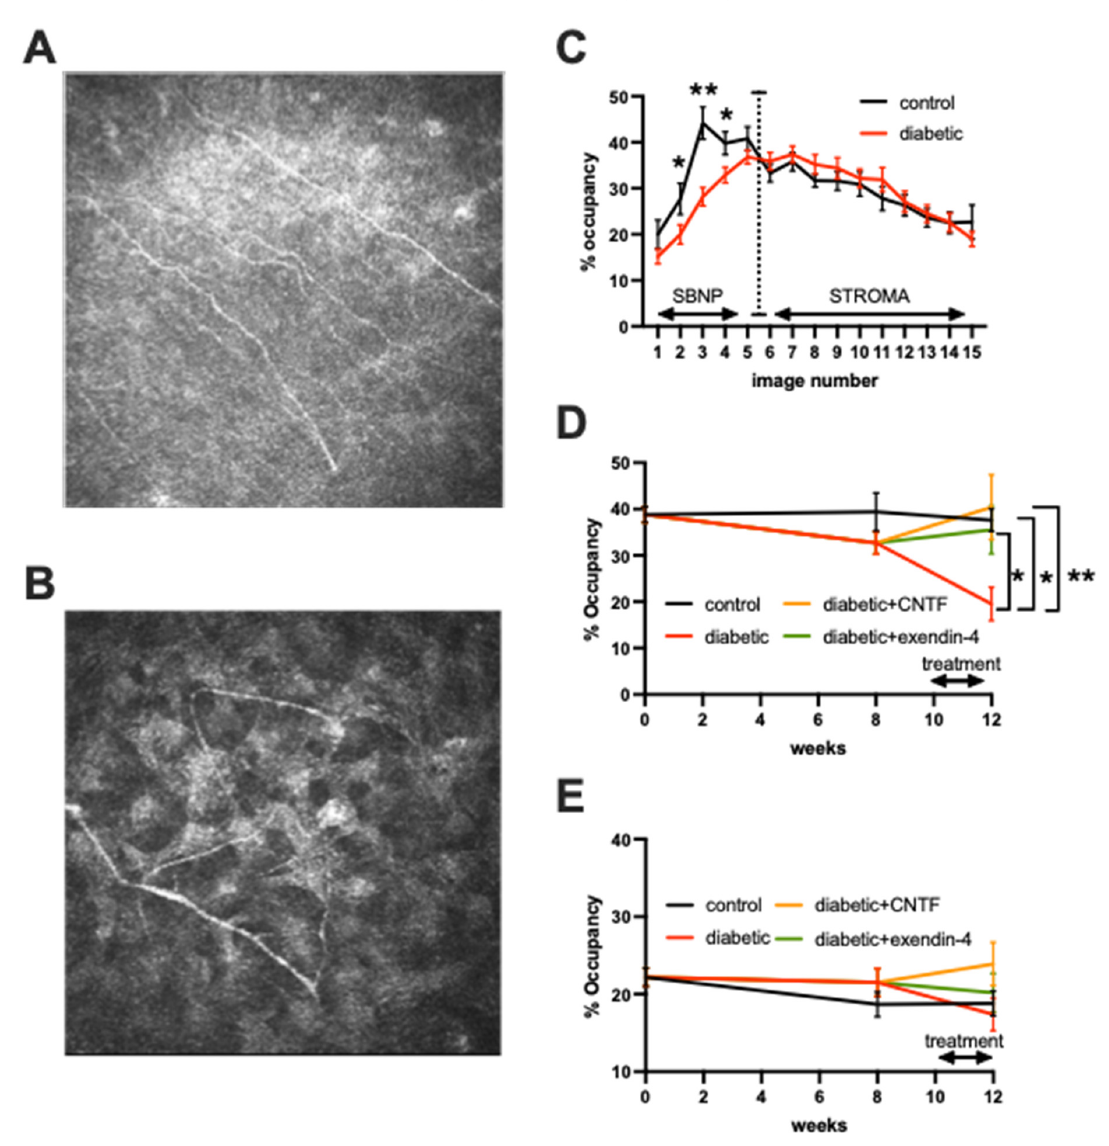
Figure 1. Reversal of corneal neuropathy by topical CNTF or exendin-4 in diabetic mice. Repre- sentative images of sub-basal nerve plexus ( A ) and stromal nerves ( B ) from Swiss Webster mice. Quantification of nerve % occupancy ( C ) of 15 consecutive individual images collected at 2 µ m intervals from the corneal epithelium to the stroma in control mice and mice with 4 weeks of diabetes. Data points are group mean ± SEM of N = 9 control and N = 23 diabetic mice. * = p < 0.05 and ** = p < 0.01 by unpaired test. Quantification of sub-basal nerve plexus ( D ) and stromal nerve ( E ) % occupancy over time in control (N = 9) mice, diabetic mice (N = 9), and diabetic mice treated daily for the last 2 weeks with eyedrops containing CNTF (N = 7) or exendin-4 (N = 7). Data points are group mean ± SEM with between group analysis at study end by one way ANOVA with Dunnett’s post hoc test. * = p < 0.05 and ** = p < 0.01 vs. vehicle treated diabetic mice. Data points are group mean ± SEM with between group analysis by one way ANOVA followed by Dunnett’s Post hoc test. * = p < 0.05 and ** = p < 0.01 vs. vehicle treated diabetic